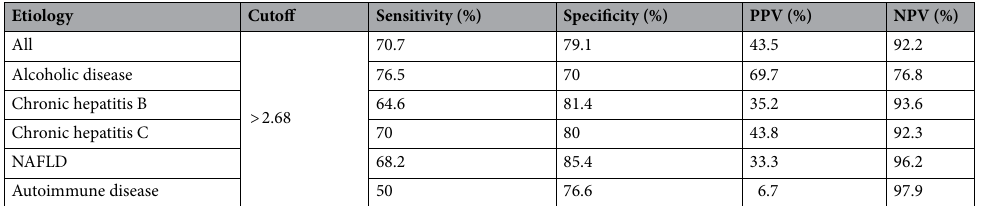
Table 4. Diagnostic performance of optimal cutoff value of FIB-4 in diagnosing advanced fibrosis. Advanced fibrosis was defined as liver stiffness greater than 4 kPa. PPV positive predictive value, NPV negative predictive value.